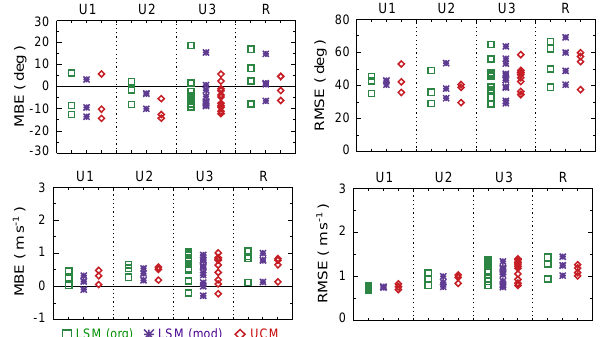
Fig. 7. Mean bias errors (MBEs) (left panels) and root mean squared errors (RMSEs) (right panels) from statistical comparison of 10-m wind direction (top) and speed (bottom) at 24 surface sites. Positive MBE in wind direction represents a clockwise bias from the observed wind